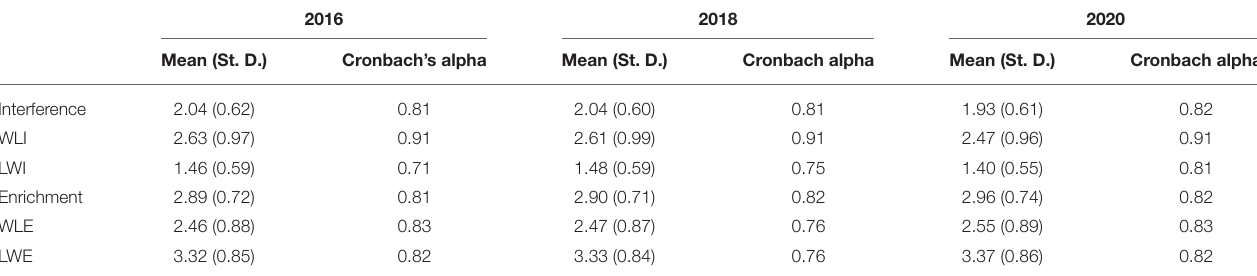
TABLE 1 | Mean values, standard deviations (in parenthesis), and Cronbach’s alpha for interference, WLI, LWI, enrichment, WLE, and